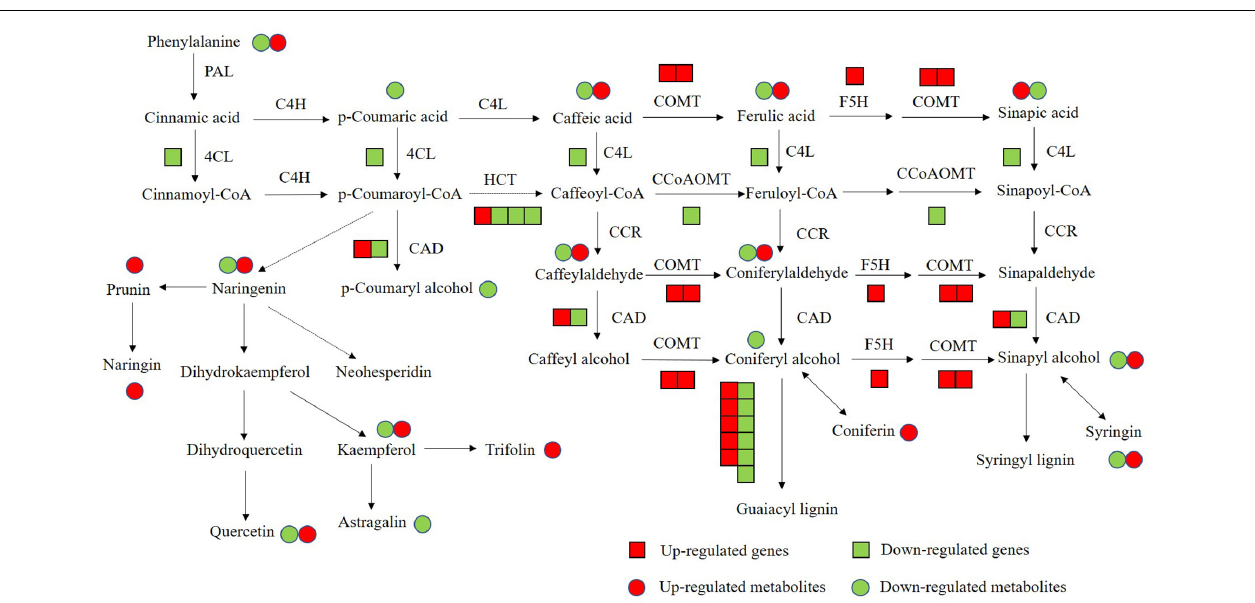
FIGURE 10 | The conjoint analysis of genes and metabolites changed in phenylalanine pathway between WT plants and OE-MsASMT1 transgenic plants. The square represents changed genes, the circle represents changed metabolites. And red color represents the up-regulated genes or metabolites, green represents the down-regulated genes or